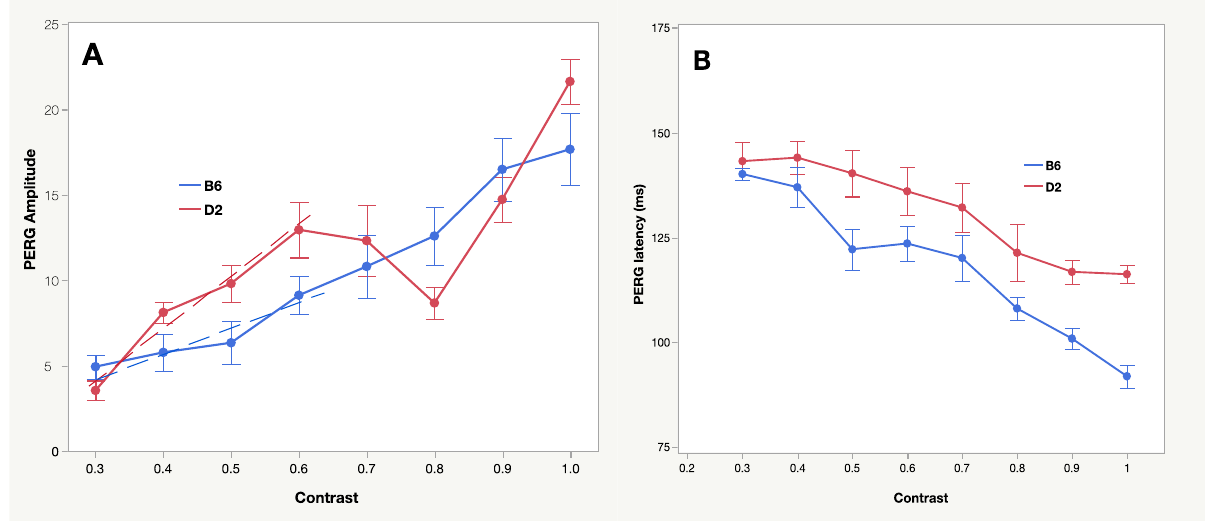
Figure 5. Contrast transfer function of PERG amplitude ( A ) and latency ( B ) in different mouse strains. B6: C57BL/6J; D2: DBA/2J. A: Different slopes of dashed lines represent different contrast gains of B6 and D2 PERGs. The dip in response amplitude at 0.8 contrast in the D2 contrast function indicates that generators with different spatio-temporal properties interact resulting in a reduction in the summed response. Replotted from Porciatti et al., 2010.